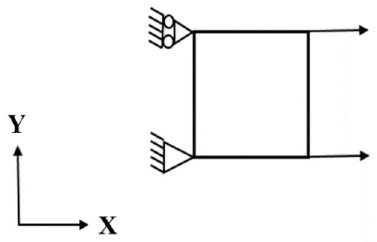
Figure 2. Finite element model for tension-compression test.